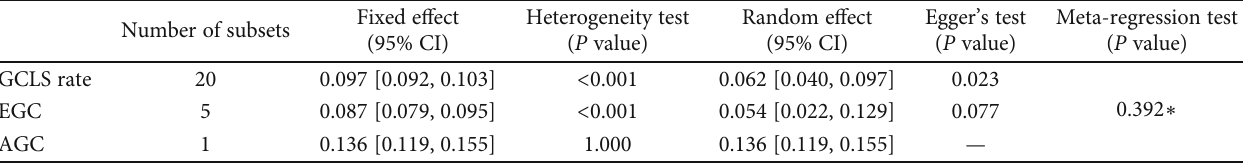
Table 2: The estimated rates of gastric carcinoma with lymphoid